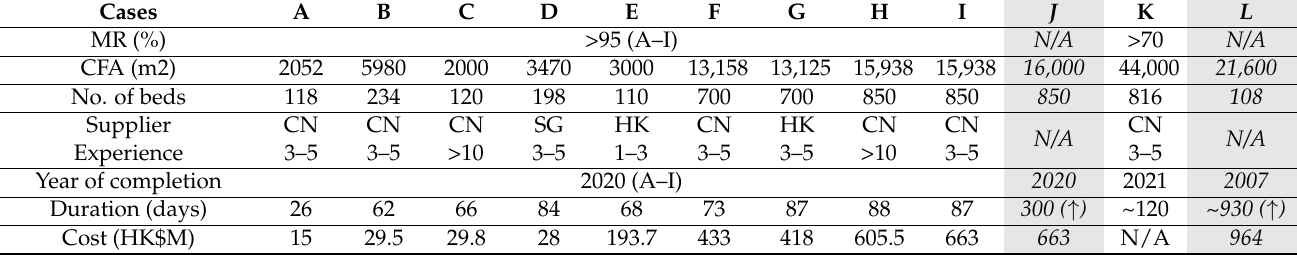
Table 1. Information of the selected case projects.